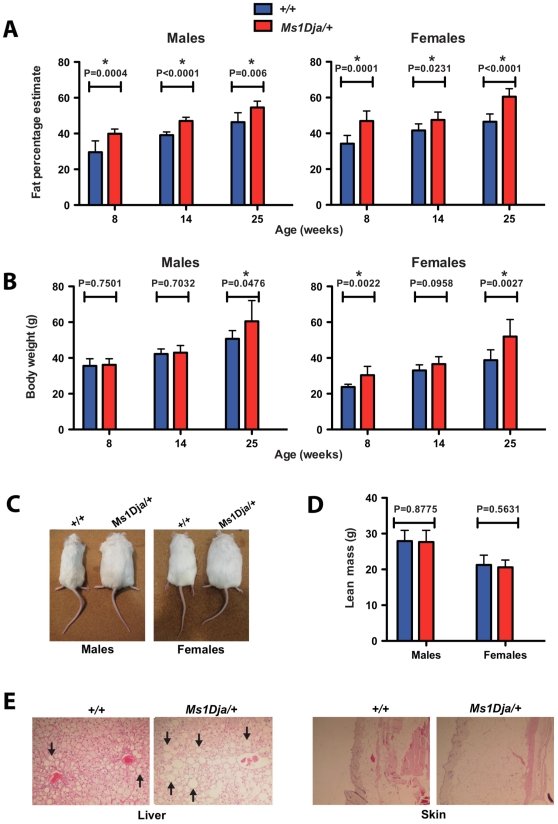
Analysis of high-fat diet-fed monosomic mice at different ages.DEXA results showing (A) fat percentage estimate and (B) body weight measurements in 8-, 14- and 25-week old male (n = 8, n = 7 and n = 8, respectively) and female (n = 8, n = 7 and n = 10, respectively) control (+/+) and male (n = 9, n = 7 and n = 7, respectively) and female (n = 10, n = 6 and n = 9, respectively) monosomic (Ms1Dja/+) littermates fed a high-fat diet. Asterisks indicate statistical significance (two-tailed Student's t-test). The error bars represent the standard deviation of the measurements. (C) Photos of 25-week old male and female control (+/+) and monosomic (Ms1Dja/+) littermates fed a high-fat diet. (D) DEXA results showing lean mass measurements in 25-week old male (n = 8) and female (n = 10) control (+/+) and male (n = 7) and female (n = 9) monosomic (Ms1Dja/+) littermates fed a high-fat diet. Analyzed with two-tailed Student's t-test. The error bars represent the standard deviation of the measurements. (E) Haematoxylin and eosin-stained liver and skin sections from 25-week old wildtype (+/+) and monosomic (Ms1Dja/+) littermates fed a high-fat diet. Note markedly increased number and size of adipose cells in liver sections from monosomic (Ms1Dja/+) mice compared to wildtype (+/+) littermates (highlighted by black arrows). Images are representative and taken at ×100 magnification.